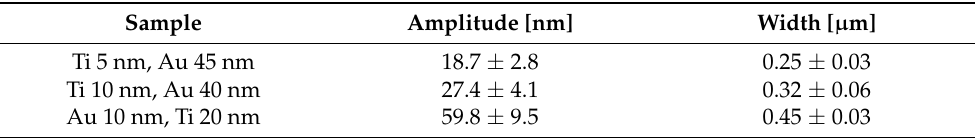
Figure 7. AFM images of heated samples with the size of 10 μm. ( a ) Ti and Au layers of 20 nm and 10 nm, respectively; ( b ) Ti and Au layers of 10 nm and 40 nm, respectively; ( c ) Ti and Au layers of 5 and 45 nm, respectively. Table 2. The average values of amplitudes and widths of wrinkles generated by sample sputtering; determined from 3 × 3 µ m AFM